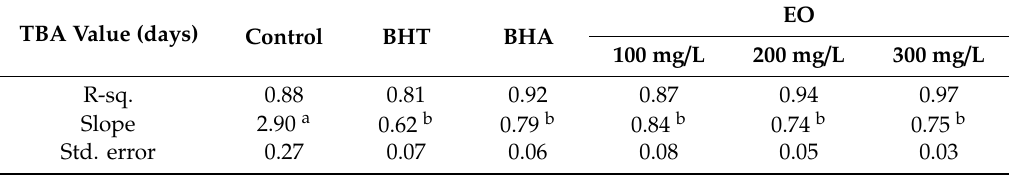
Table 5. Linear regression analysis of TBA value with storage period as independent variable. TBA Value (days)